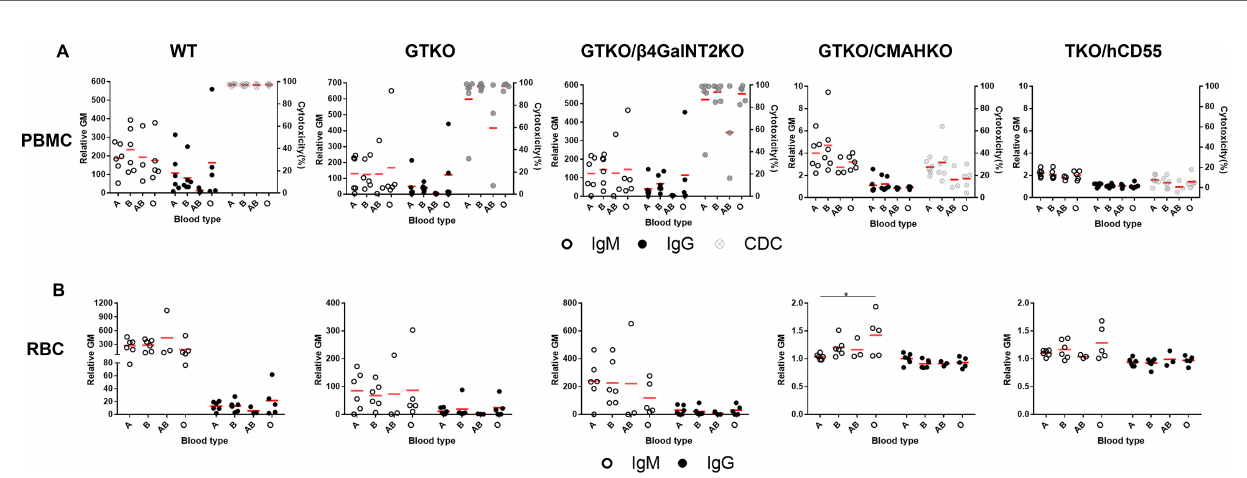
FIGURE 6 | Comparison of IgM/IgG binding and CDC to PBMCs or RBCs from WT, GTKO, GTKO/ b 4GalNT2KO, GTKO/CMAHKO and TKO/hCD55 pigs in sera from healthy human volunteers of different ABO blood types. (A) There were no differences in IgM (left) or IgG (middle) binding or CDC (right) to WT, GTKO, GTKO/ b 4GalNT2KO, GTKO/CMAHKO, and TKO/hCD55 PBMCs in sera from humans of various ABO blood types. (B) There were no differences in IgM (left) or IgG (right) binding to WT, GTKO, GTKO/ b 4GalNT2KO, and TKO/hCD55 RBCs, but IgM binding to GTKO/CMAHKO RBCs was signi fi cantly lower in sera from A blood type subjects than in those of O blood type.